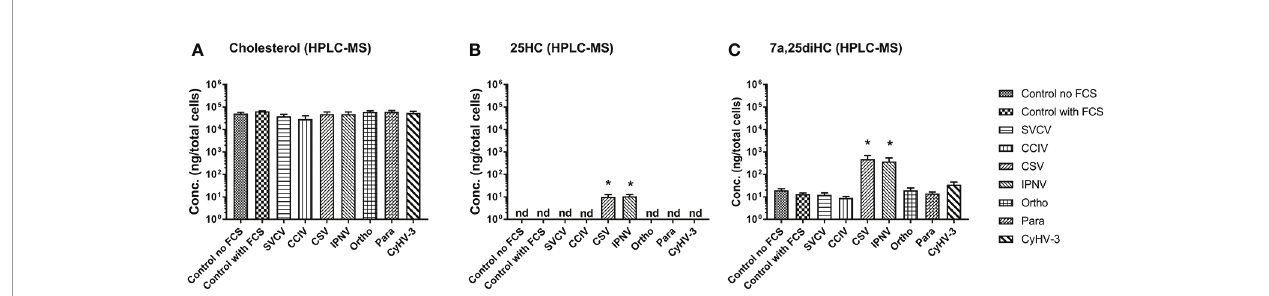
FIGURE 4 | Concentration of (A) cholesterol and (B, C) oxysterols, (B) 25-hydroxycholesterol (25HC), and (C) 7 a 25hydroxycholesterol (7 a ,25diHC) in carp cells 24 h post-infection with various viruses replicating in carp cells, as determined by high performance liquid chromatography-atmospheric pressure chemical ionization- mass spectrometry (HPLC-MS). The cells were infected with: spring viremia of carp virus (SVCV), cyprinid herpesvirus 1 (CyHV-1), cyprinid herpesvirus 3 (CyHV-3), infectious pancreas necrosis virus (IPNV), chum salmon reovirus (CSV), an uncharacterized birnavirus isolate infecting carp (Birna), common carp iridovirus (CCIV), an orthomyxovirus infecting carp (Ortho), a paramyxovirus from carp (Para). Data presented as a bar indicating mean concentration (+SD) per 8 x 10 6 cells from n = 4 replicates. * indicates a statistically signi fi cant difference at p<0.05 between control and infected cells. Analysis was performed with one-way ANOVA with subsequent pairwise multiple comparisons using the